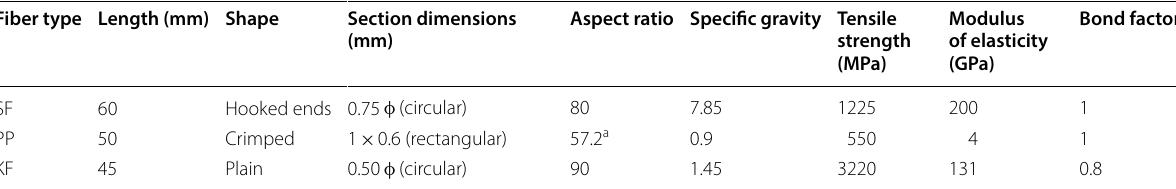
a Calculated using equivalent